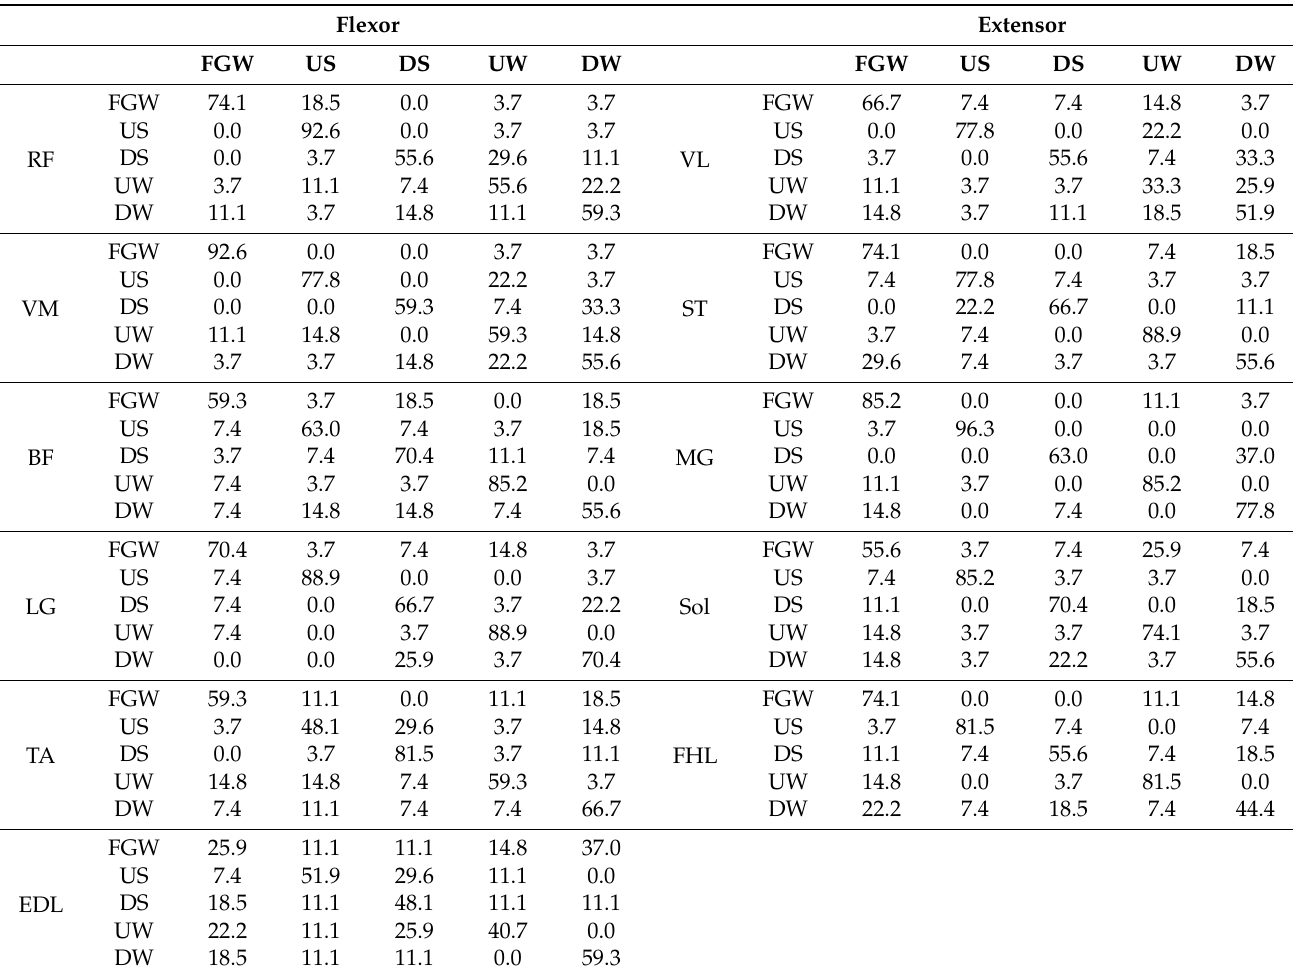
Table 6. The confusion matrix for classifying the walking environment using only sEMG signals from the individual muscles around the ankle, knee, and MTP joints.